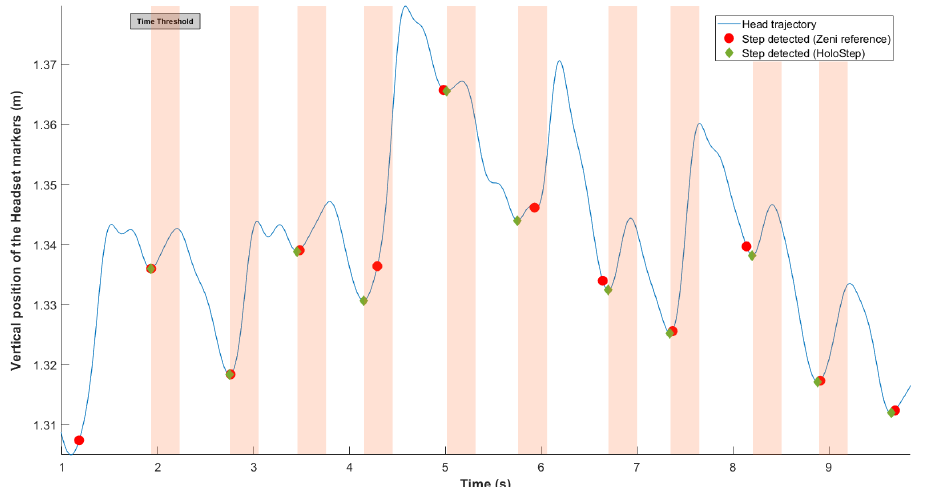
Figure 3. Representation of the locking time threshold. In blue, vertical head position y F of the user wearing the AR HMD over the walkway. The green diamonds were the IC detected with HoloStep. The red circle were IC detected with Zeni algorithm reported to y F . The orange bands were the locking time threshold (minimum peaks ignored by HoloStep).